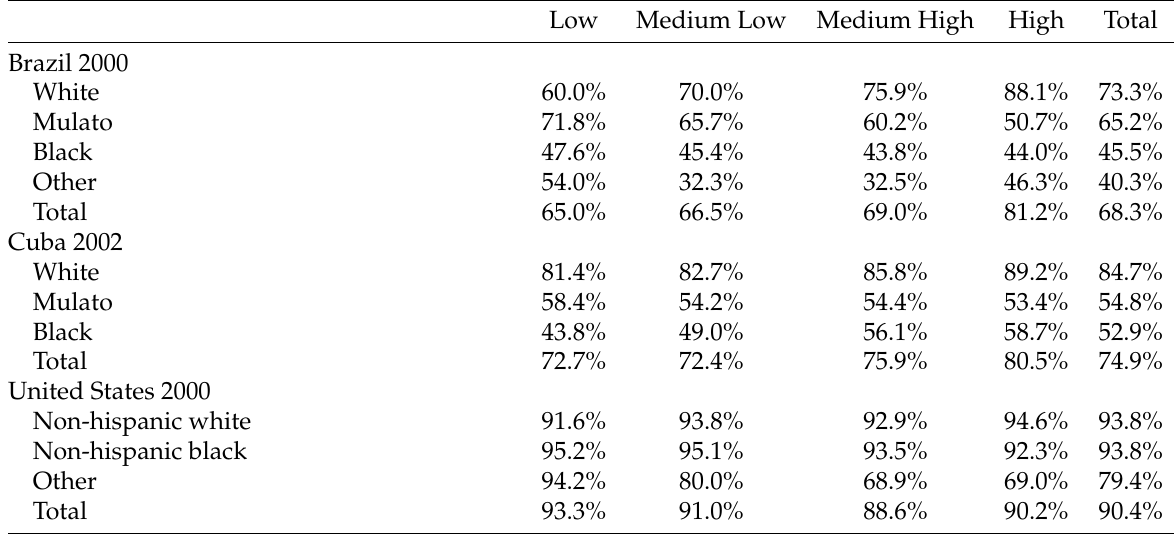
Table 2: Percentage of endogamous unions by race and educational attainment; women in unions aged 25 to 34 (Brazil 2000, Cuba 2002, and the United States